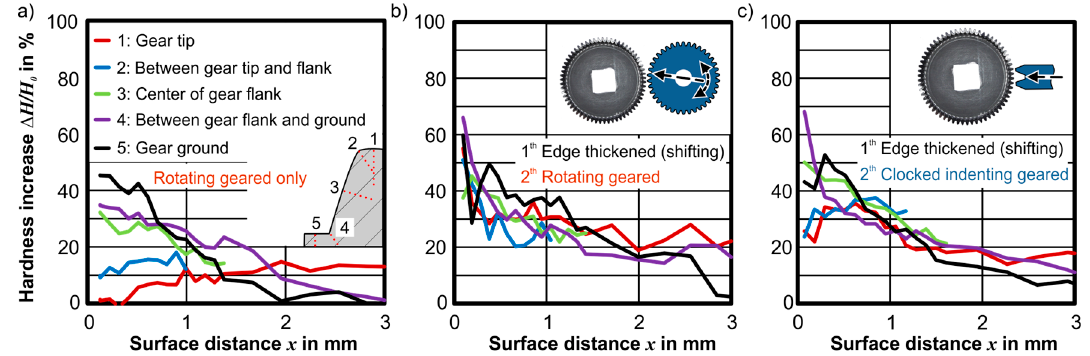
Figure 8. Hardness distribution in gears made of BS 600 steel ( H 0 = 208 HV0.1) after gear forming with